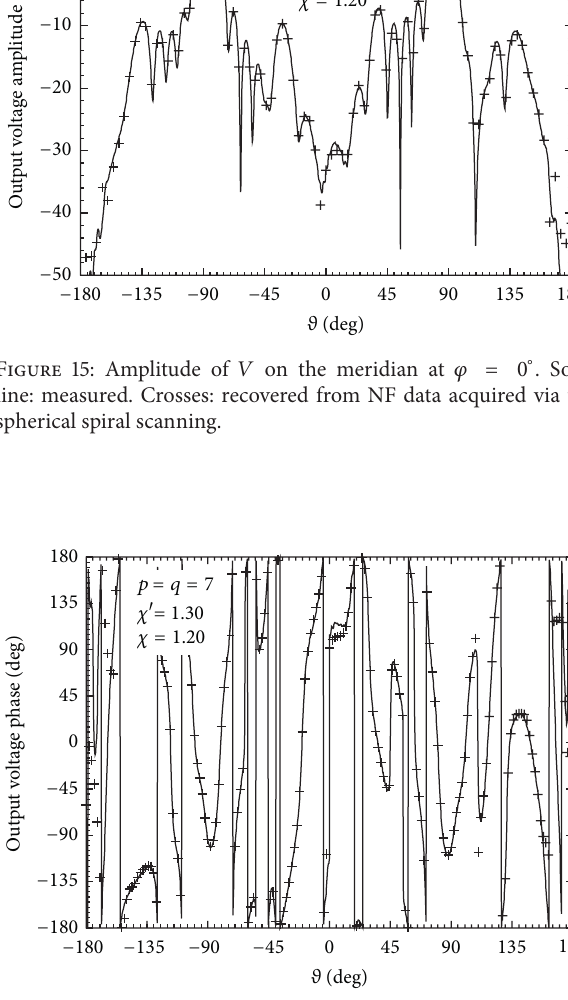
Figure 16: Phase of 𝑉 on the meridian at 𝜑 = 0 ∘ . Solid line: measured. Crosses: recovered from NF data acquired via the spherical spiral scanning.